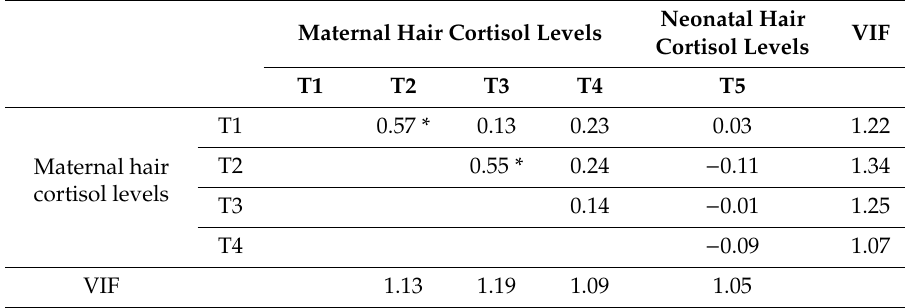
Table 2. Pearson’s correlations between maternal and infant hair cortisol